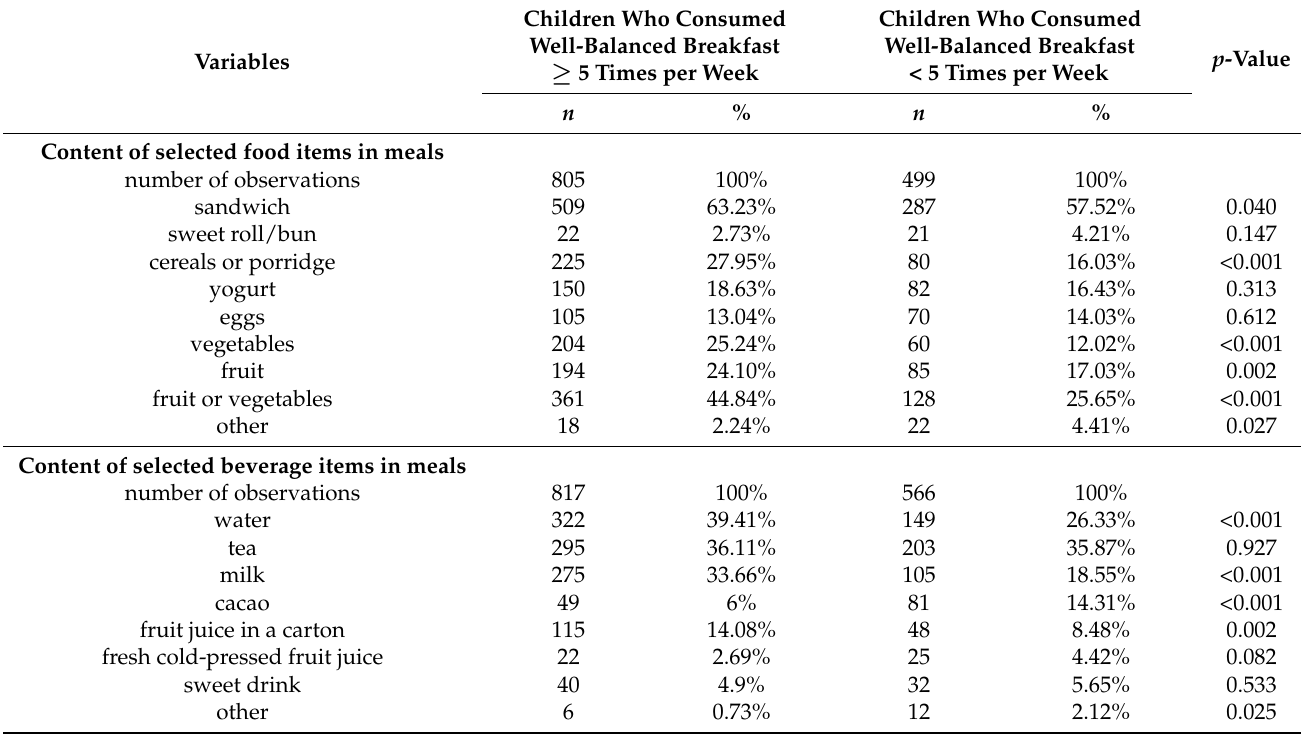
Table 4. Content of selected food and beverage items in analyzed meals in group of children who consumed well-balanced breakfast 5 or more days per week or less than 5 days per week.